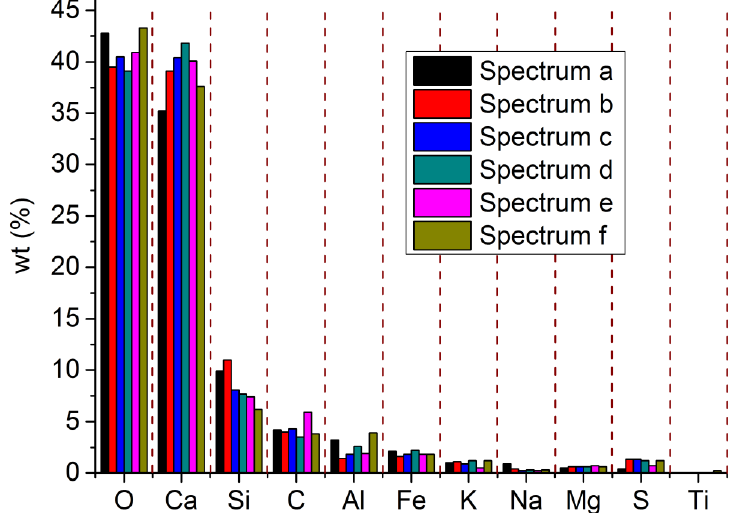
Figure 6. EDS spectrums of composite Portland cement P.C 42.5 R.